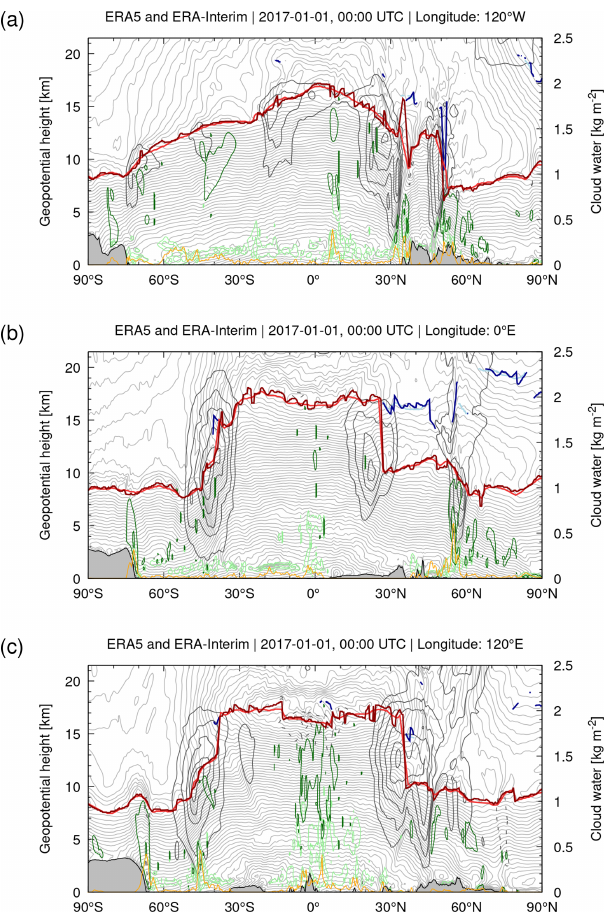
Figure 3. Meridional cross sections of ERA5 (dark red) and ERA- Interim (light red) WMO first tropopause and ERA5 (dark blue) and ERA-Interim (light blue) WMO second tropopause geopoten- tial heights on 1 January 2017, 00:00UTC, at (a) 120 ◦ W, (b) 0 ◦ E, and (c) 120 ◦ E. Light gray curves are ERA5 temperature contours at levels of 2K. Dark gray curves are ERA5 zonal wind contours at 20, 30, 40, 50, 60, and 70ms − 1 (solid) and − 20 and − 30ms − 1 (dashed). Dark green and light green curves show contours of the ERA5 cloud ice and liquid water content at levels of 0.01, 0.1, 1, and 10gkg − 1 , respectively. The orange curve indicates the ERA5 total column cloud water. Gray shaded areas at the bottom of the plots indicate topography. The cross sections were sampled at 0.3 ◦ in latitude and 150m in height.